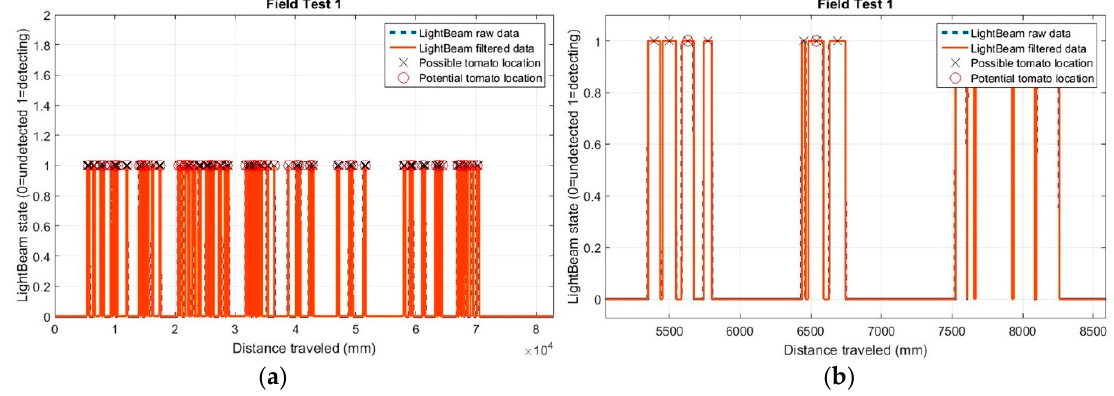
Figure 9. ( a ) Detections and positions of the 41 tomato plants in first field test with IR sensors; and ( b ) detail of the positions of potential plants.